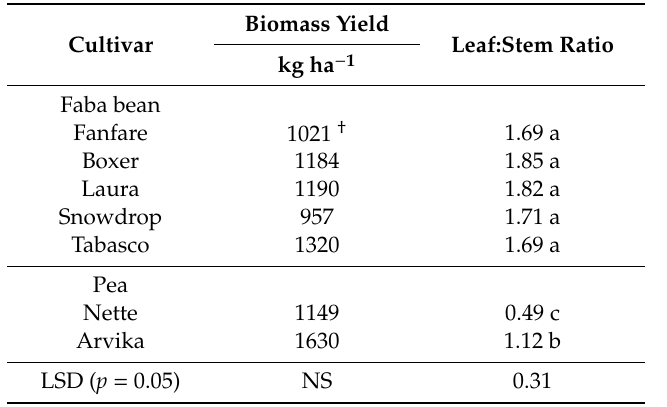
Table 6. Cover crop biomass yield and leaf:stem ratio averaged across four environments at Hickson and Prosper, ND, USA, in 2017 and